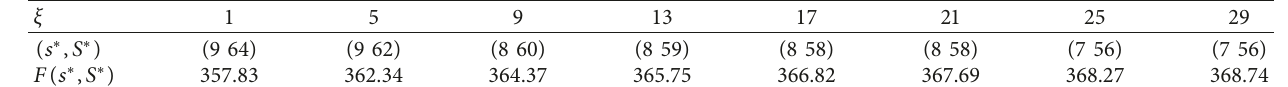
Table 5: The effect of the parameter ξ on the optimal policy and the optimal cost.